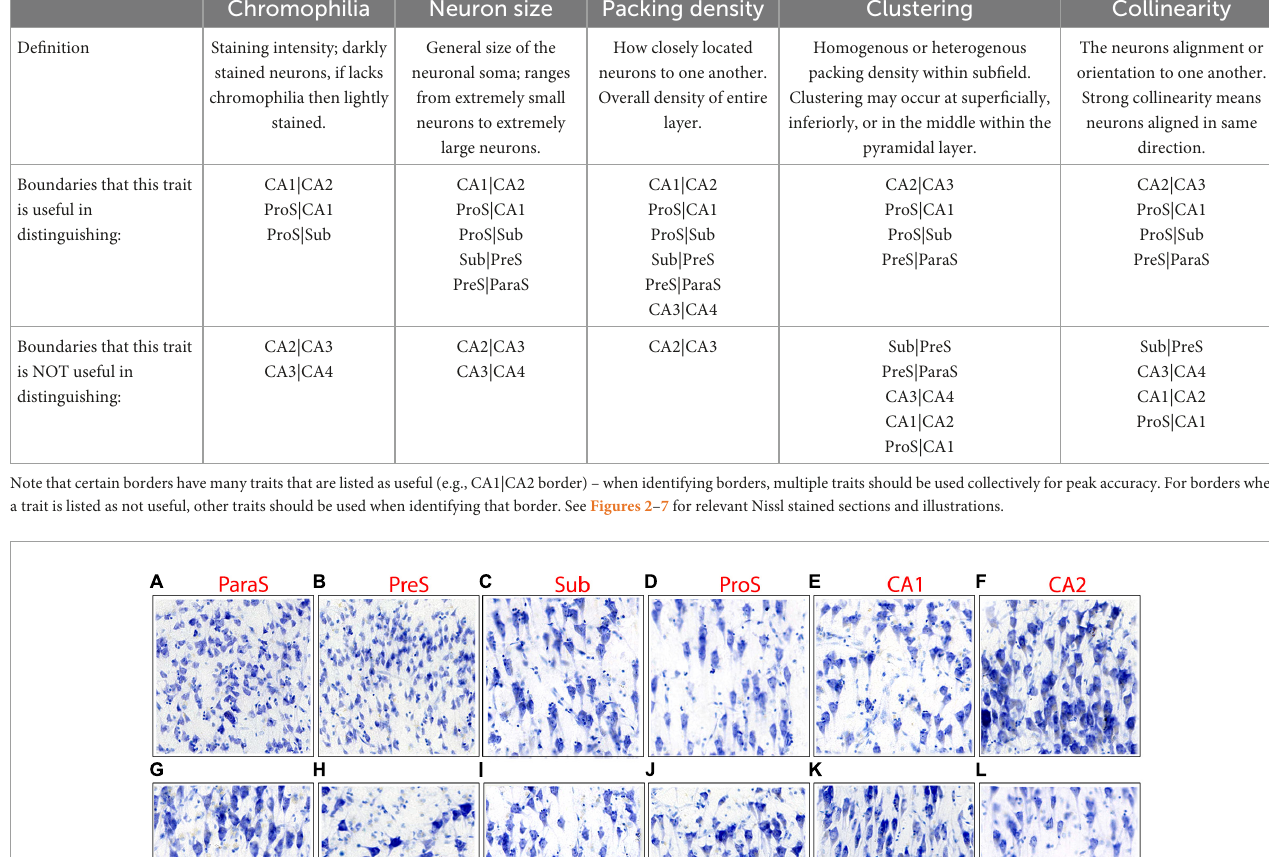
TABLE 3 Pentad protocol’s cytoarchitectural traits, their definitions, and where they are most and least applicable. Chromophilia Neuron size Packing density Clustering Collinearity